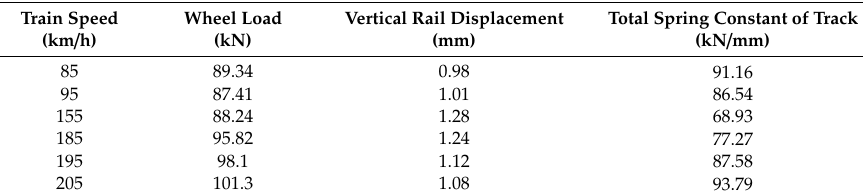
Table 13. Total spring constant of concrete track (Field measurement).